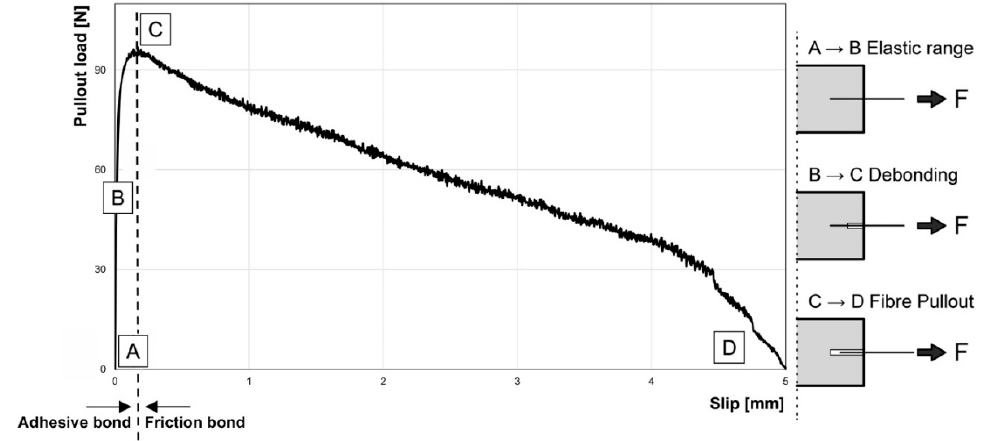
Figure 2. Typical fibre pullout diagram (fibre pullout load versus slip curve) of straight steel fibres (based on [19]).